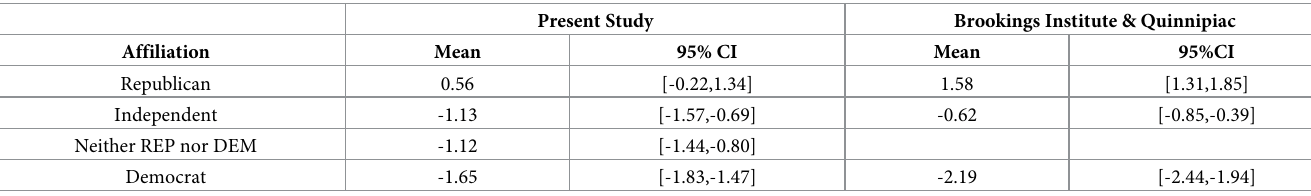
Table 1. Trump approval score A P broken down by party